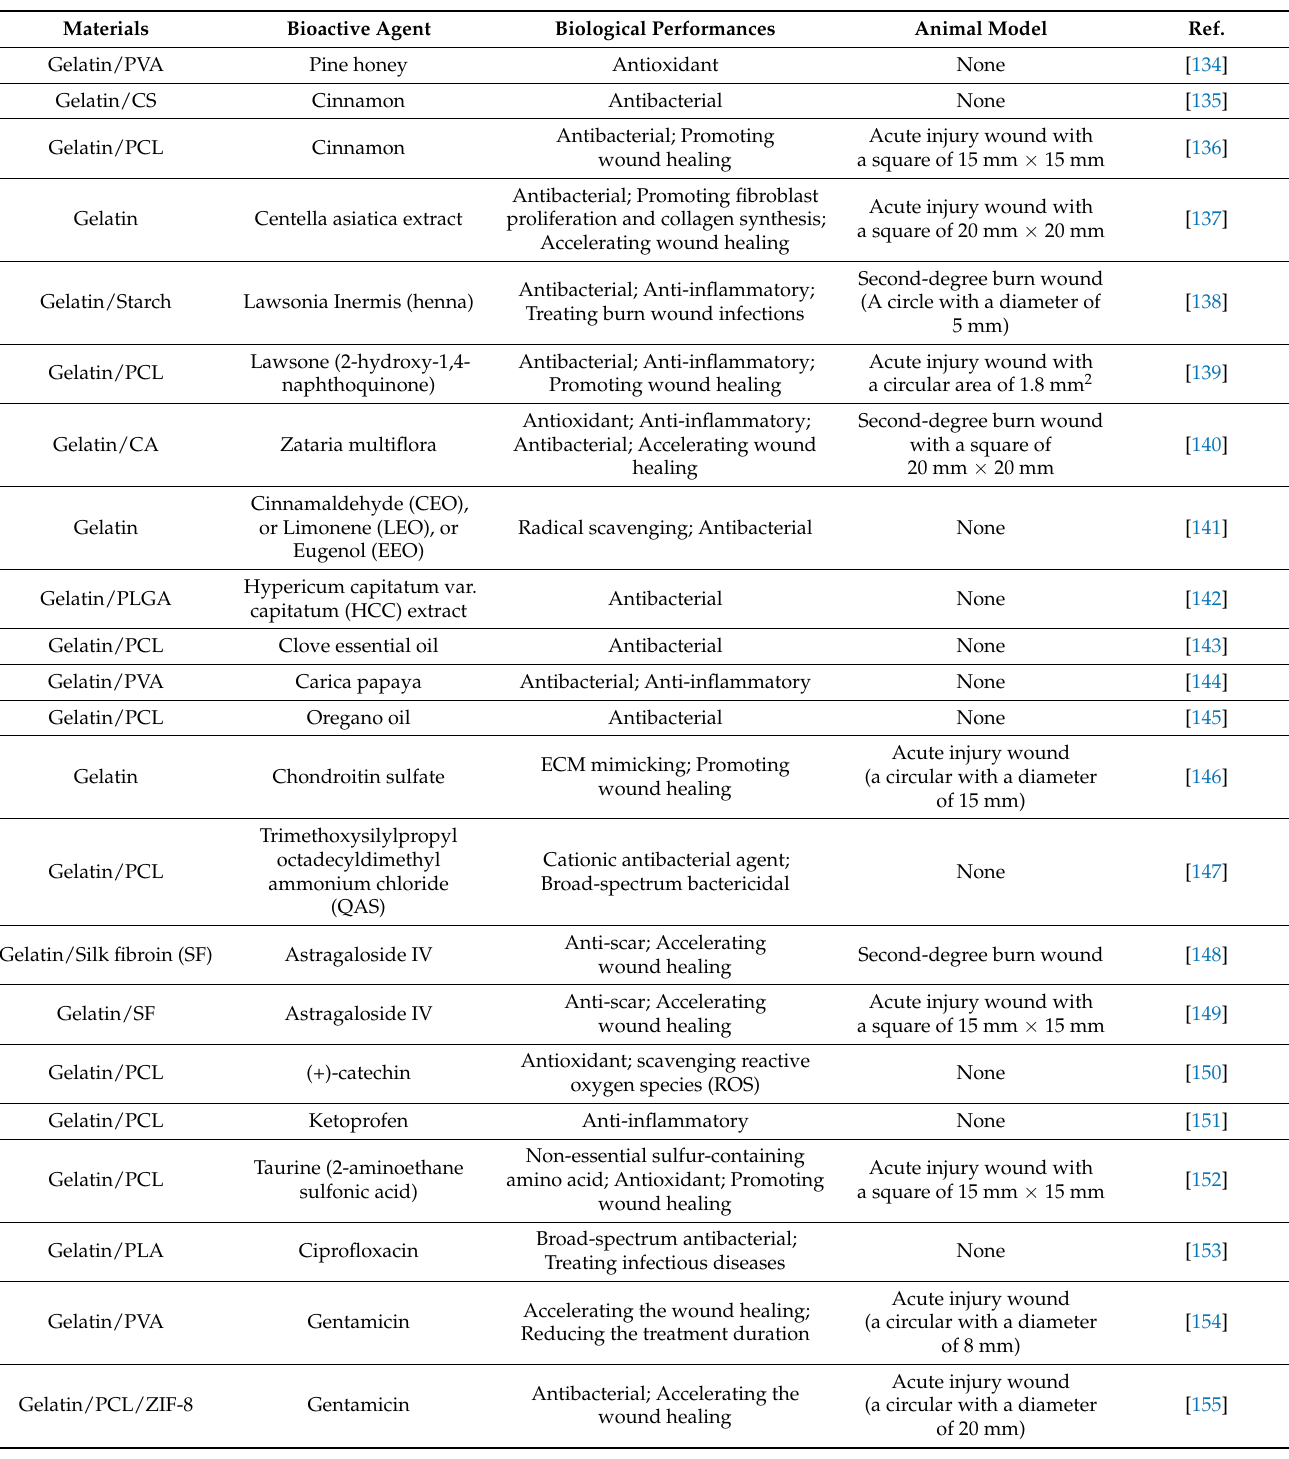
Table 2. Lists of some representative bioactive and therapeutic components introduced into electro- spun gelatin-based nanofiber mats for wound